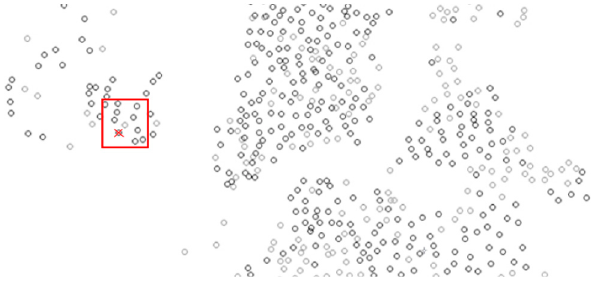
Figure 15. Example of window search performed on bike stations of Citi Bike, New York.